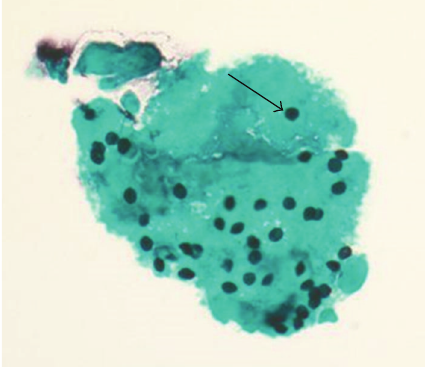
Figure 2: Grocott’s methenamine silver (GMS) stain of bron- choalveolar lavage specimen demonstrating black staining round cysts (arrow) in the alveolar exudate diagnostic of Pneumocystis jiroveci pneumonia.